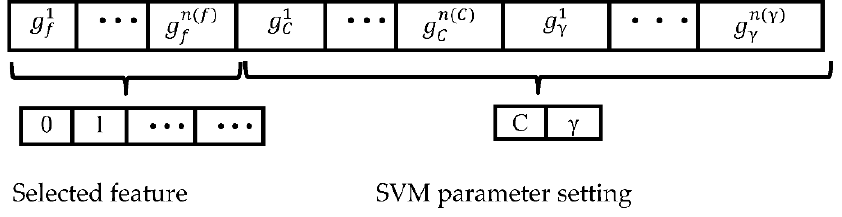
Figure 4. The chromosome design. SVM: support vector machine.